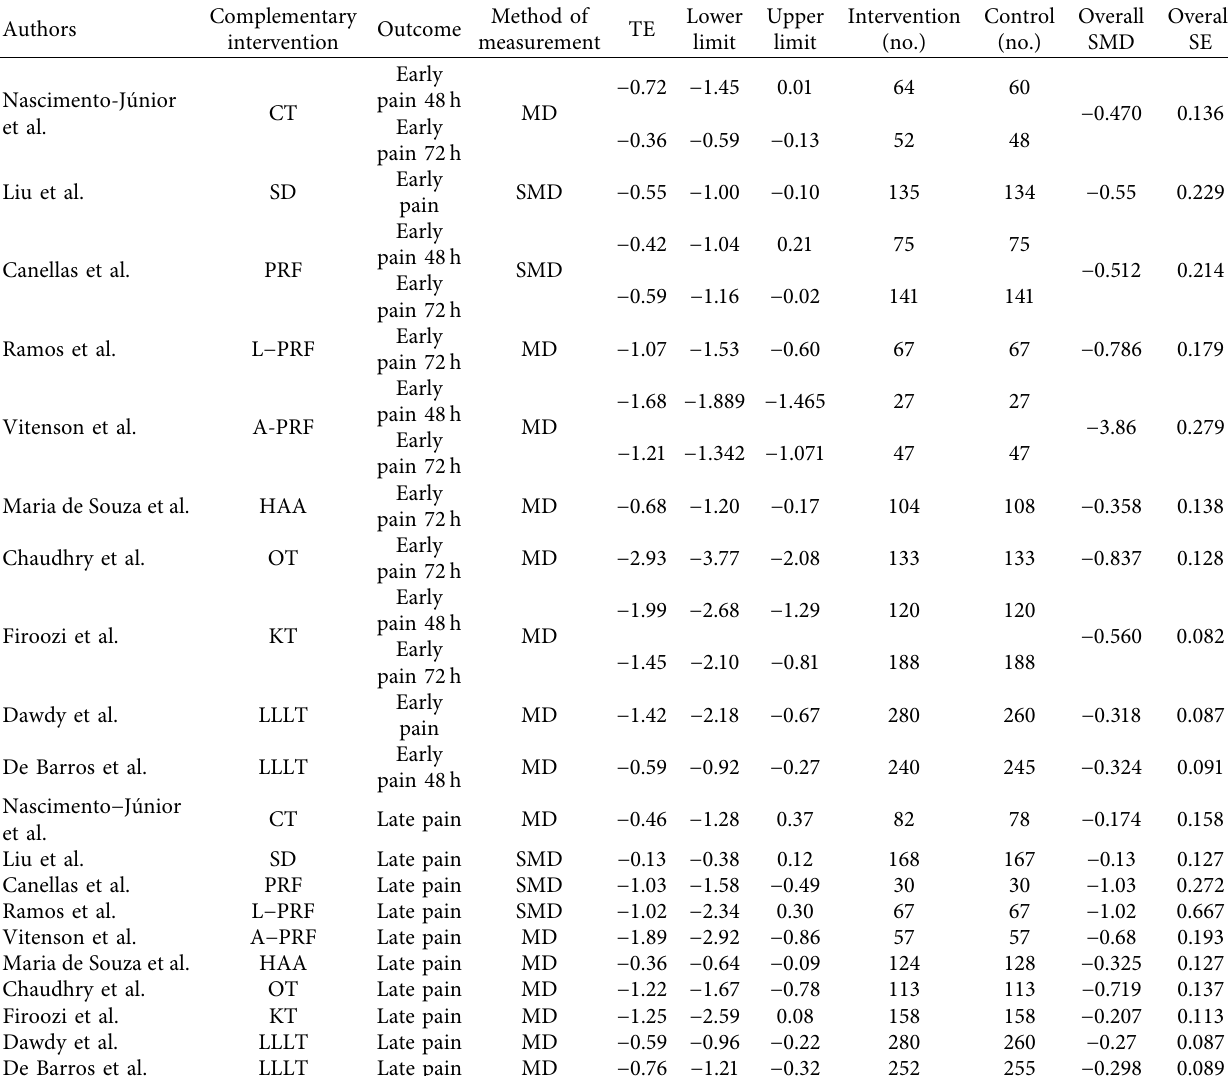
Table 2: Treatment effects of different complementary